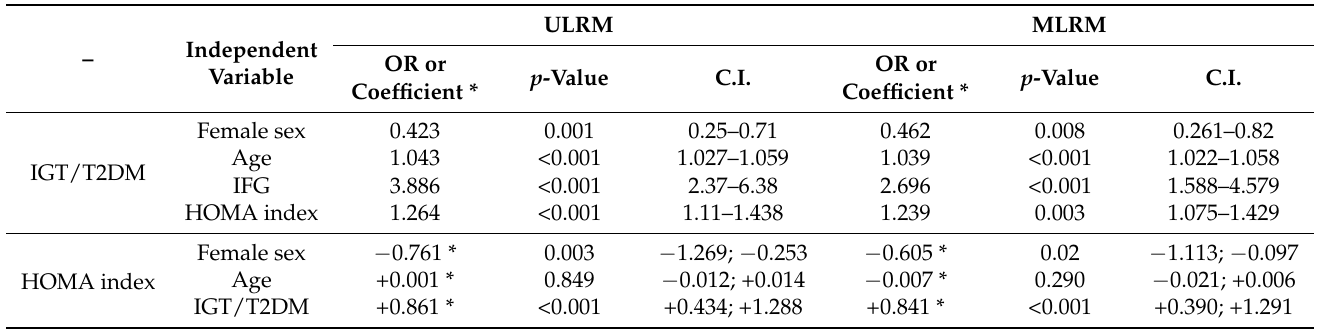
Table 6. Univariable and multivariable logistic regression models with IGT/T2DM, IFG and HOMA index as main